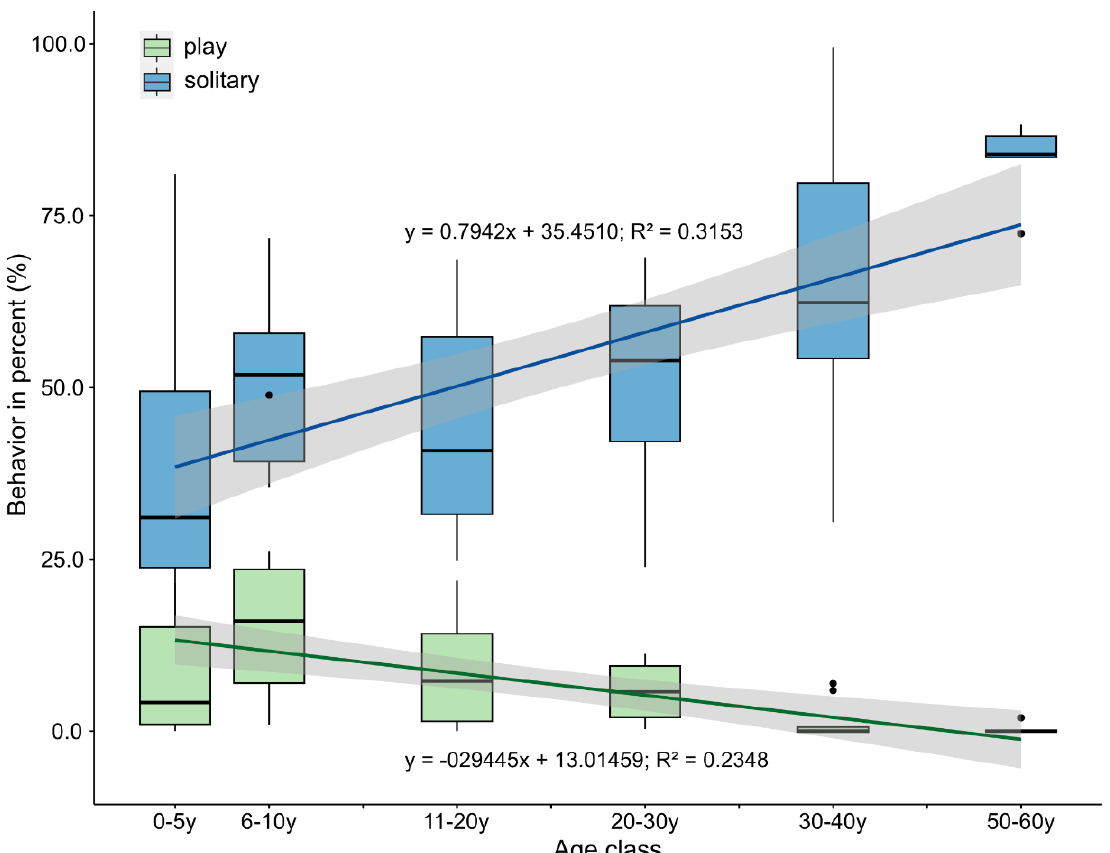
Figure 3. Age dependencies of play and solitary behavior. Play behavior decreased, and solitary behavior increased with increasing age. We used age categories to plot these dependencies.